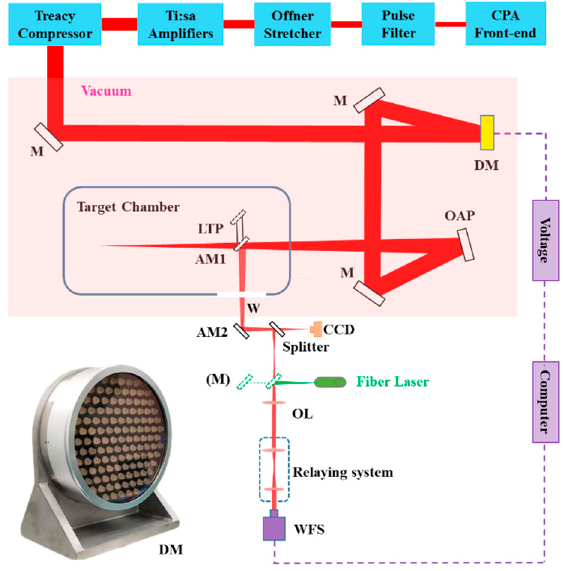
Figure 1. Experimental setup of SULF-1PW laser beamline. AM 1–2, partial reflection mirrors; LTP, Linear translation platform; W, Window; OL, objective lens; WFS, Hartmann wavefront sensor.